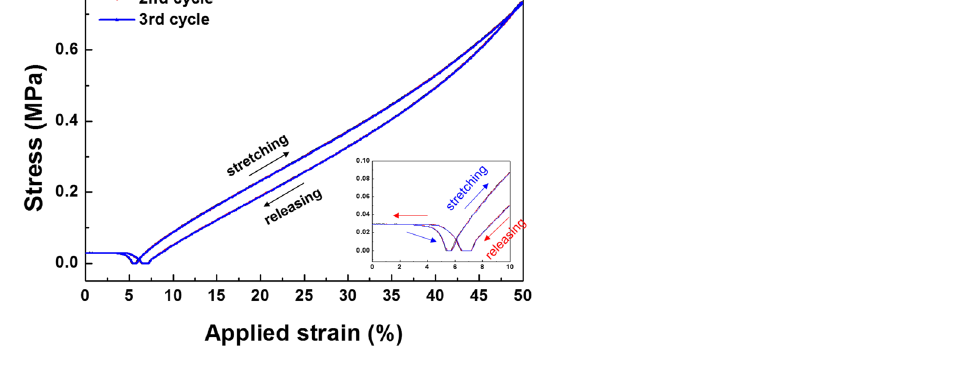
Figure 6. Stress-strain behaviour of the fabricated crack-induced strain